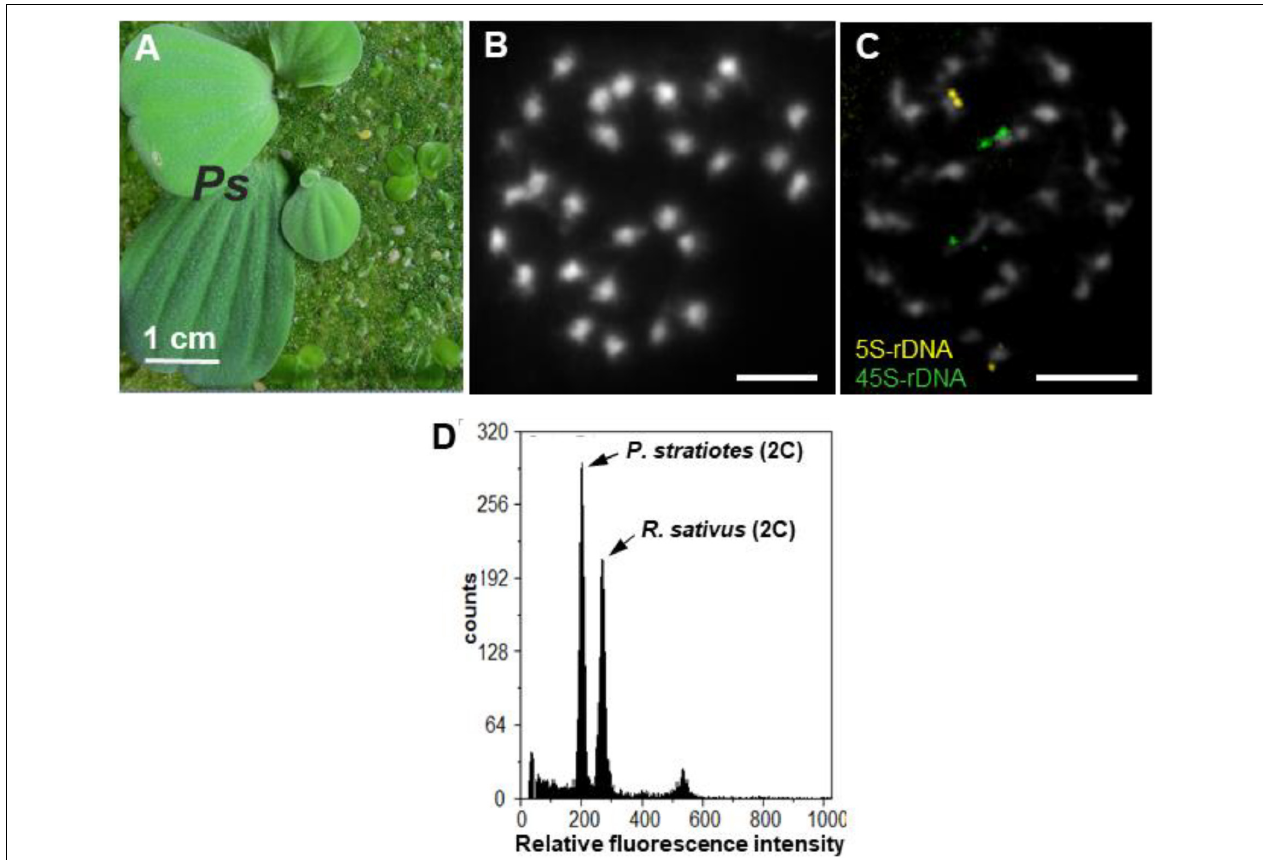
FIGURE 1 | P. statiotes , its chromosomes and nuclear DNA content. (A) Whole P. stratiotes plant ( Ps ) in the presence of different duckweed species. (B) Complete meristematic metaphase, with 28 small DAPI-stained chromosomes (scale bar: 5 µ m). (C) FISH signals for 5S (yellow) and 35S rDNA (green) loci at one end of one pair of chromosomes each (scale bar: 5 µ m). (D) Histogram of nuclear DNA of P. stratiotes, and Raphanus sativus as an internal reference standard.